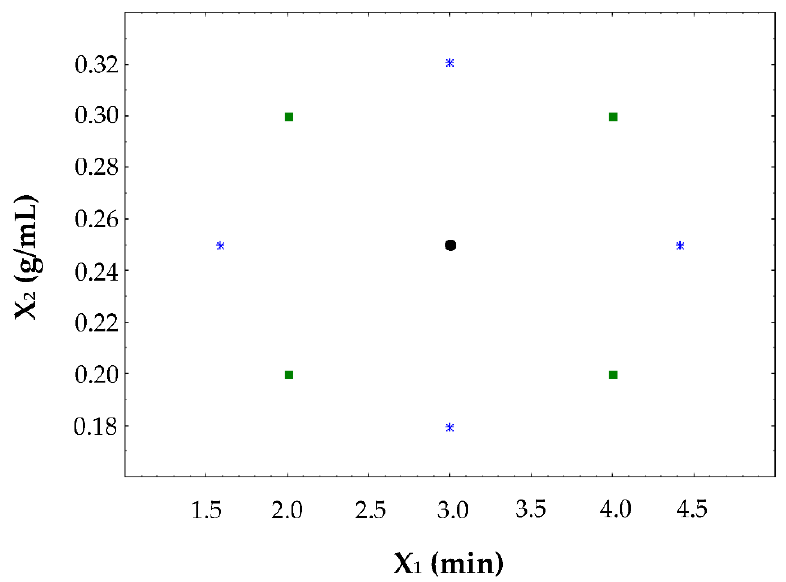
Figure 1. CCD features: four cube points (green squares), four star points (blue crosses), and four center points (black circles). X 1 : extraction time. X 2 : solvent-solid ratio.